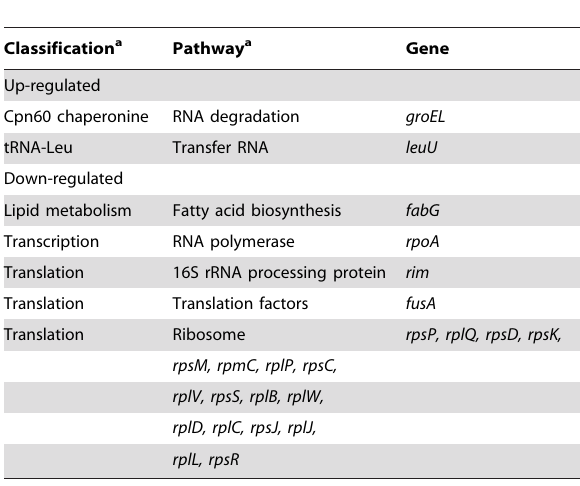
Table 3. Essential genes significantly up-regulated and down-regulated at